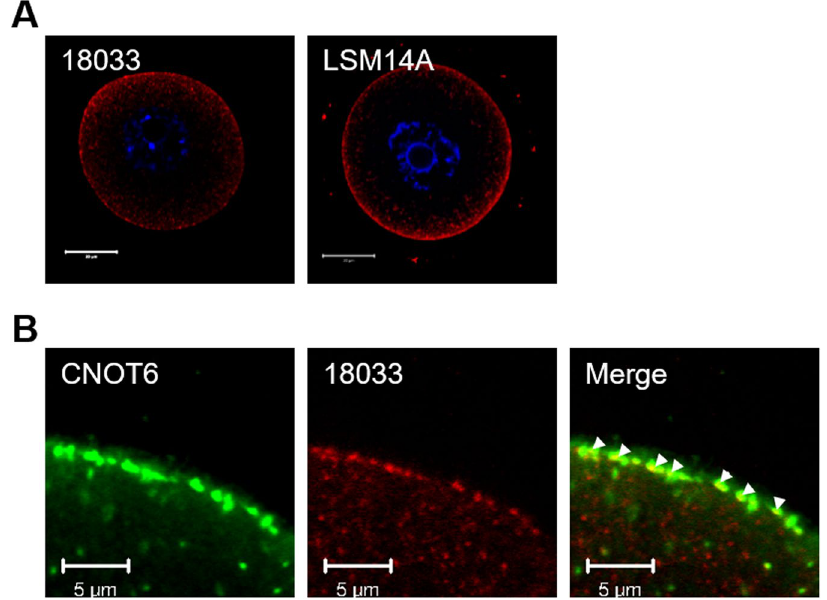
Figure 4. Co-localization of CNOT6 foci and cytoplasmic ribonucleoprotein (RNP) markers. ( A ) Whole-cell immunofluorescence of fully grown GV-stage oocytes stained for RNP markers 18033 (left panel) or LSM14A (right panel). Both are localized in the cortex. Bar = 20 µ m. ( B ) Whole-cell immunofluorescence of fully grown GV-stage oocytes co-stained for CNOT6 (green) and 18033 (red). Merged image shows overlapping foci. Bar = 5 µ m. Overlap was quantified using ImageJ (R = 0.73 ± 0.02, Rr = 0.32 ± 0.02; n =